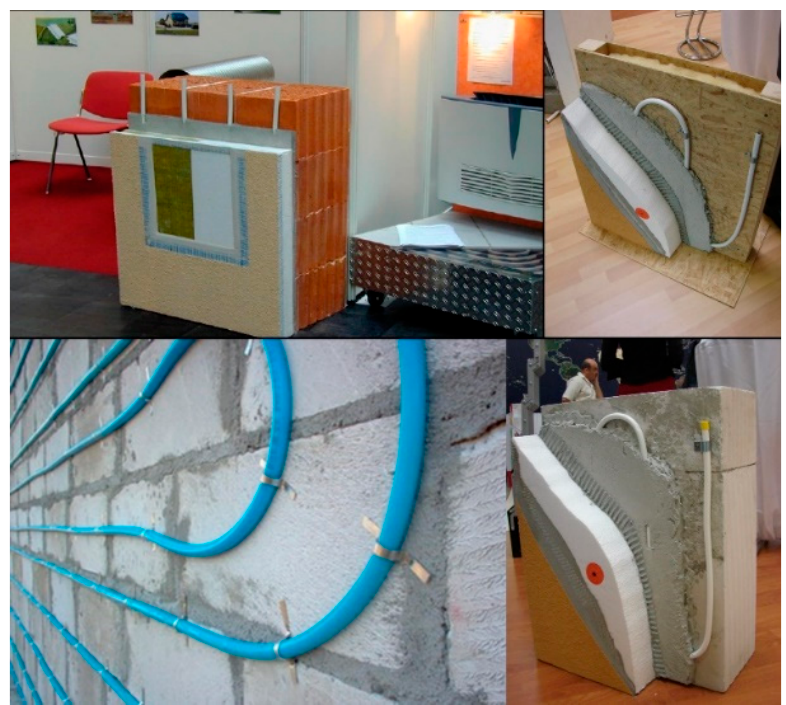
Figure 3. A thermal barrier integrated into the building construction separates the load-bearing, static portion of the perimeter wall and the thermal insulation portion [1,2].